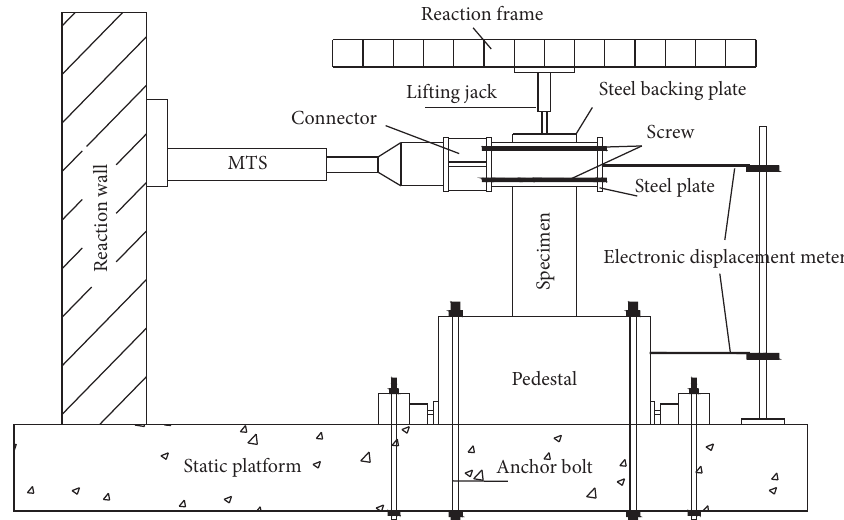
Figure 4: Experimental test set-up. MTS actuator with data acquisition system collects load and displacement data.